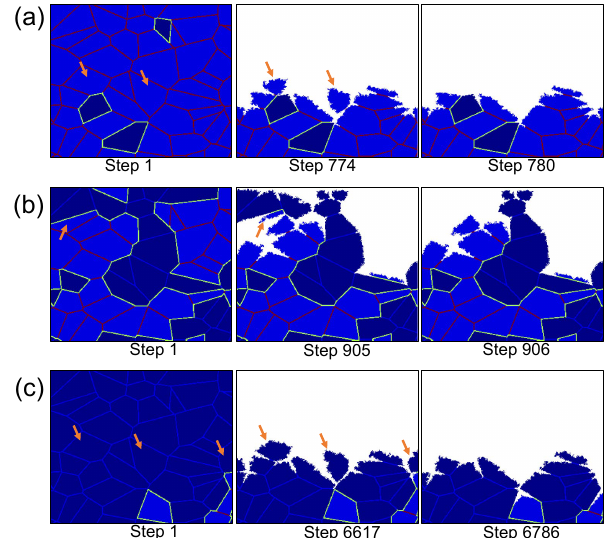
Figure 6. Simulation snapshots for three representative composi- tions. Rocks comprising (a) 10% low-reactivity minerals, (b) an equal mix of high and low-reactivity minerals, and (c) 90% low- reactivity minerals. In all simulations, the grain size is constant (relative grain size = 64). Orange arrows indicate clusters that are removed via mechanical grain detachment. Small-sized grains are detached in (a) and (c) ; in contrast, large clusters detach in (b) . Note that although (a) and (c) have similar granular structures, the overall weathering rate in (c) is almost 1 order of magnitude